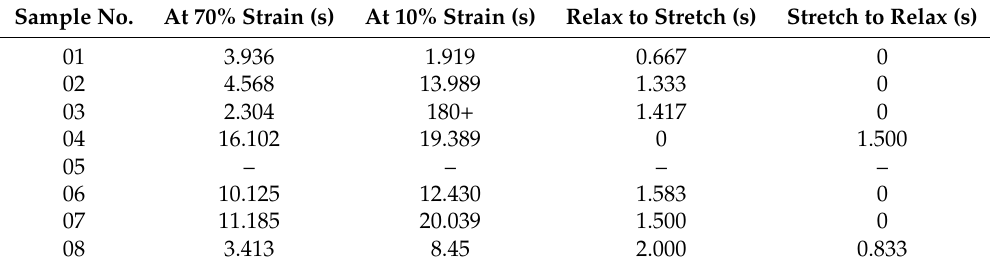
Table 7. Sensors’ response